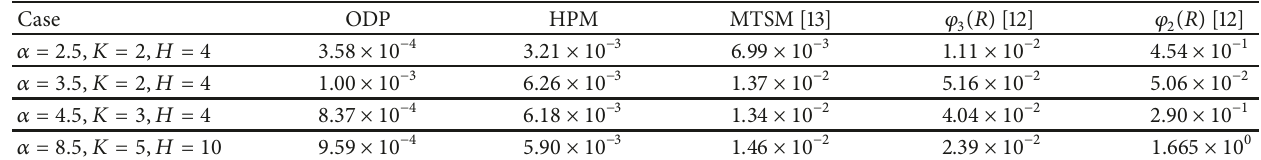
Table 1: Absolute relative error